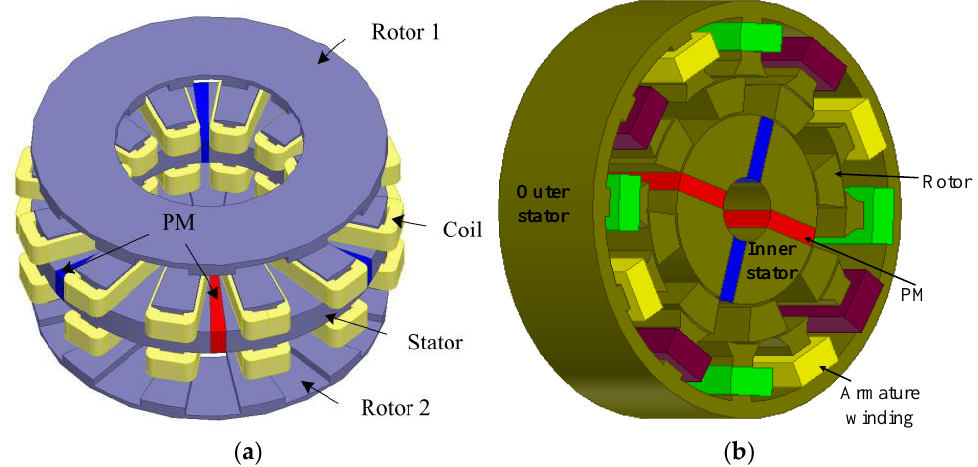
Figure 12. Emerging designs of doubly salient BSMMs: ( a ) axial-flux doubly salient motor [96]; ( b ) partitioned stator doubly salient motor.